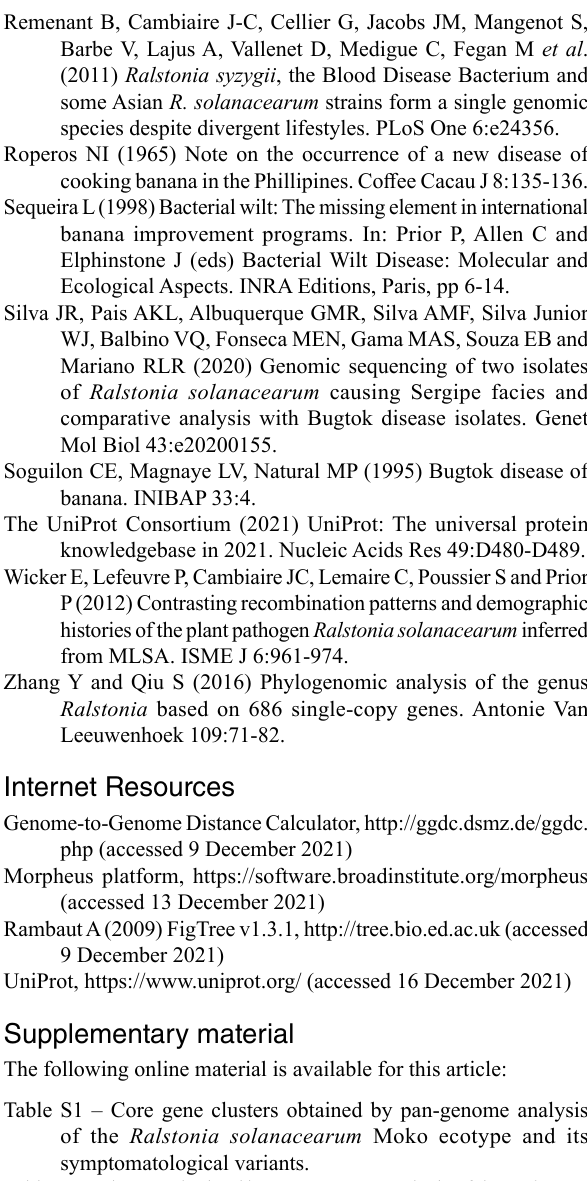
Table S1 – Core gene clusters obtained by pan-genome analysis of the Ralstonia solanacearum Moko ecotype and its symptomatological variants. Table S2 – Clusters obtained by pan-genome analysis of the Ralstonia solanacearum Moko ecotype and its symptomatological variants. Table S3 – Exclusive and shared gene clusters obtained by pan-genome analysis of the Ralstonia solanacearum Moko ecotype and its symptomatological variants. Figure S1 – Heatmap generated from in silico DNA-DNA hybridization and average nucleotide identity using the MUMmer algorithm of Ralstonia solanacearum Moko ecotype genomes and its symptomatological variants. *The upper triangle refers to the values of is DDH and the lower triangle to the values of